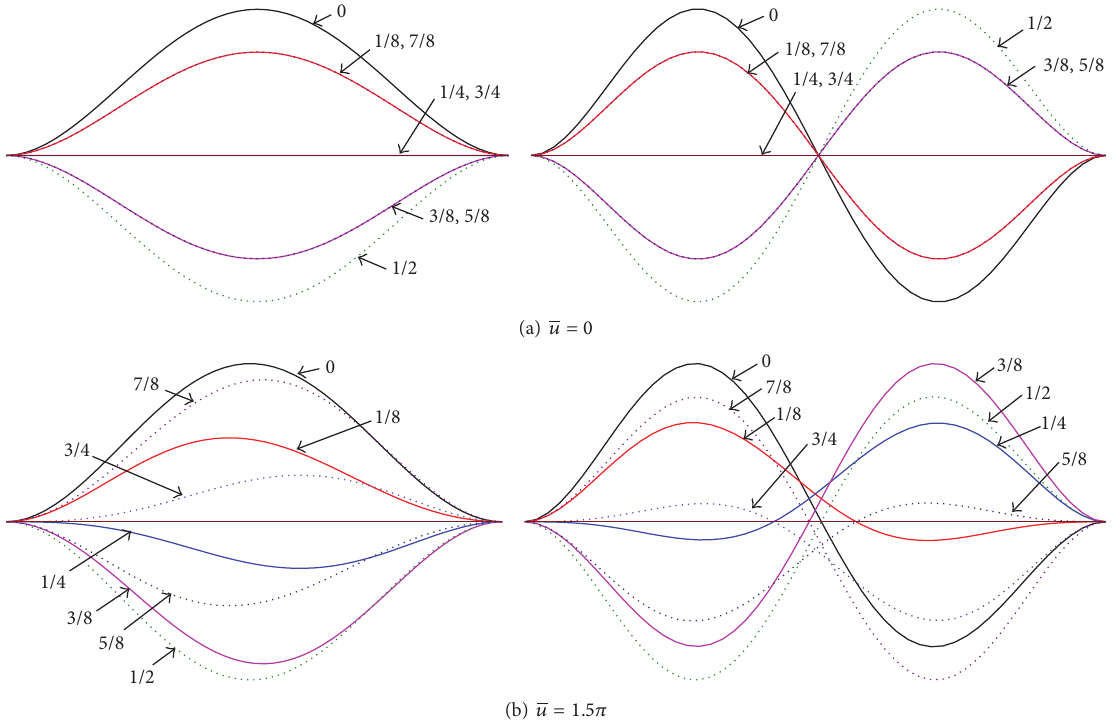
Figure 4: Variation of modal forms of the first two modes of a clamped-clamped pipe during a period of oscillation.